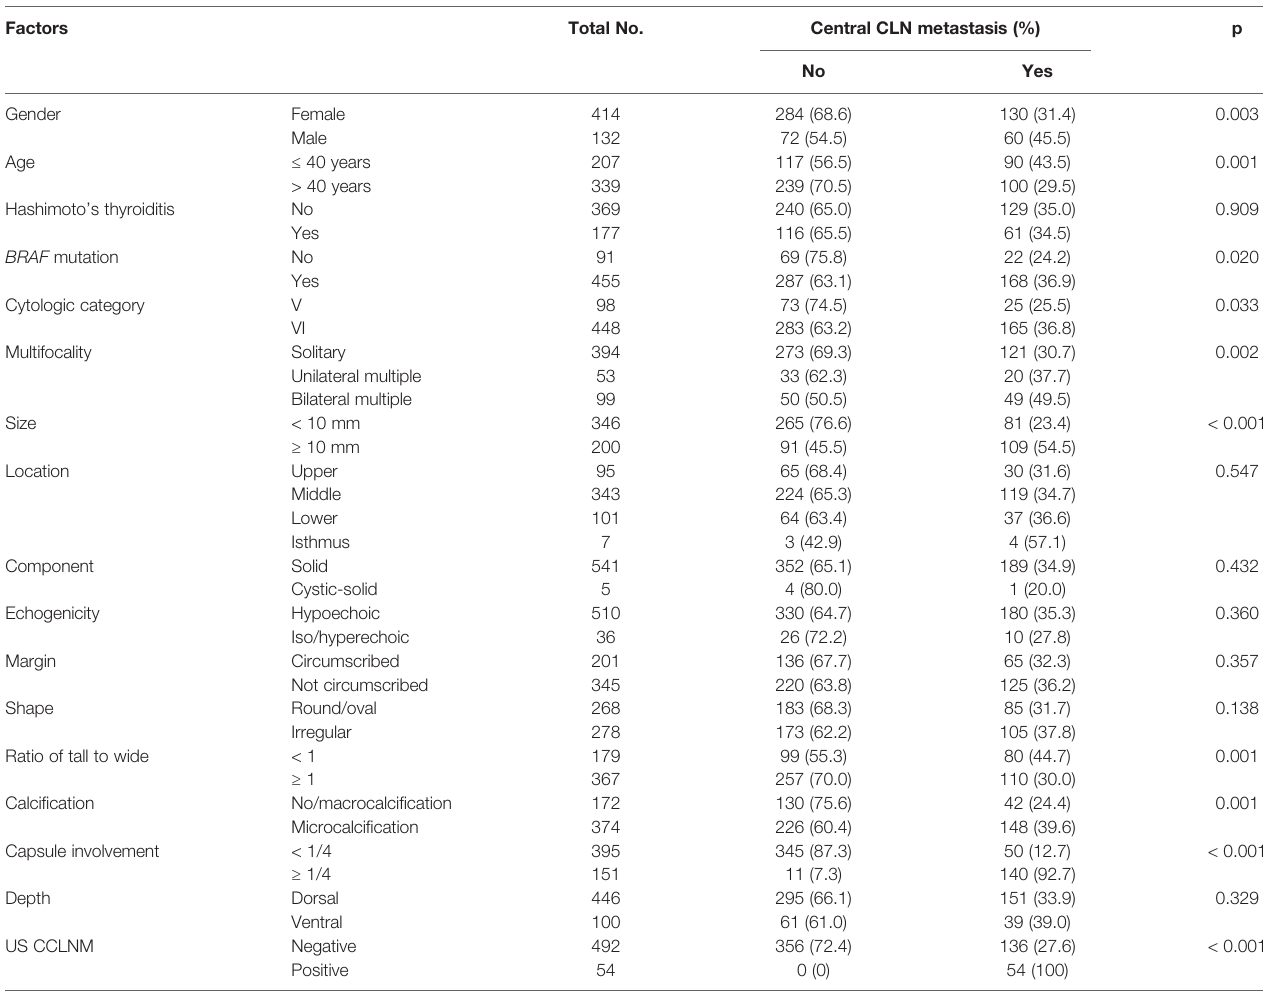
TABLE 2 | Univariate